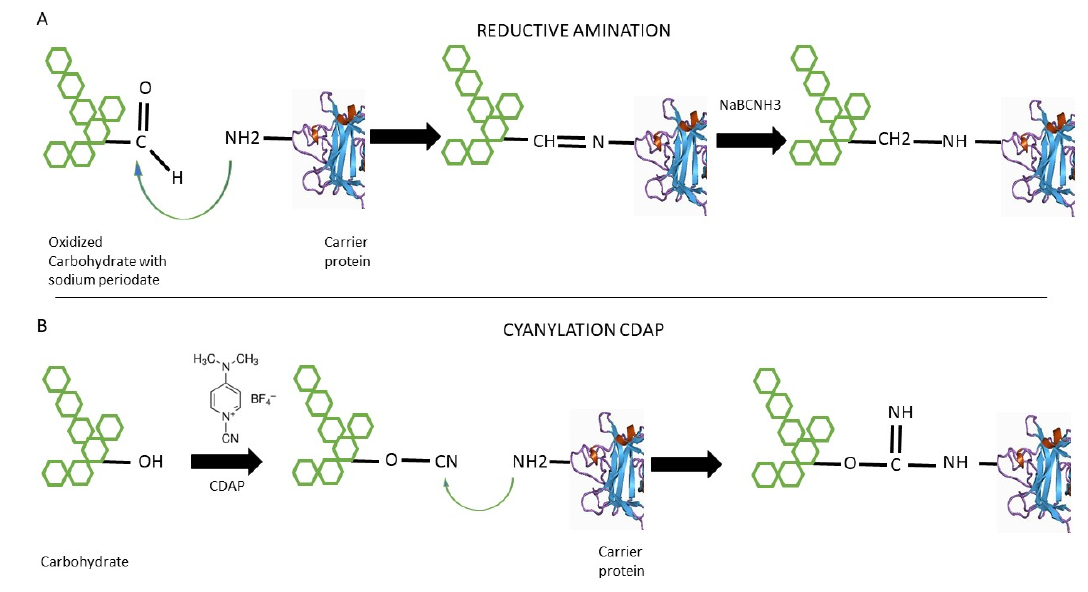
Figure 1. Conjugation by Reductive Amination and CDAP.